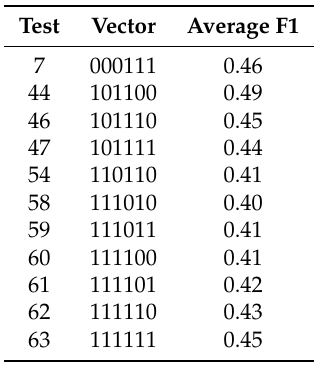
Table 14. ISFB Dataset—Highest Performing Feature